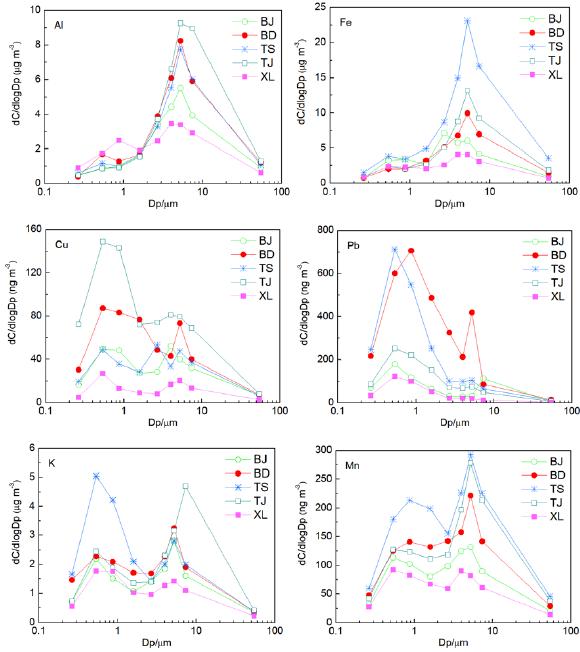
Figure 4. Size distribution of aerosol trace elements in Northern